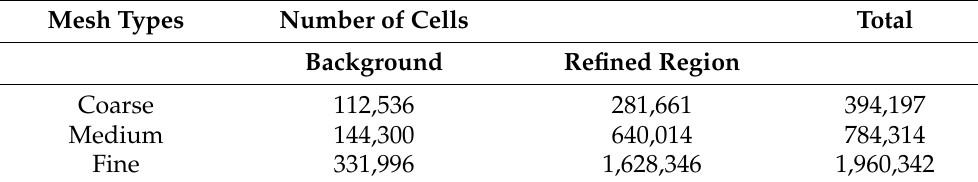
Figure 8. z-directional motion of the center of gravity of the device with different mesh resolutions. Table 1. The breakdown of different types of mesh applied in mesh sensitivity